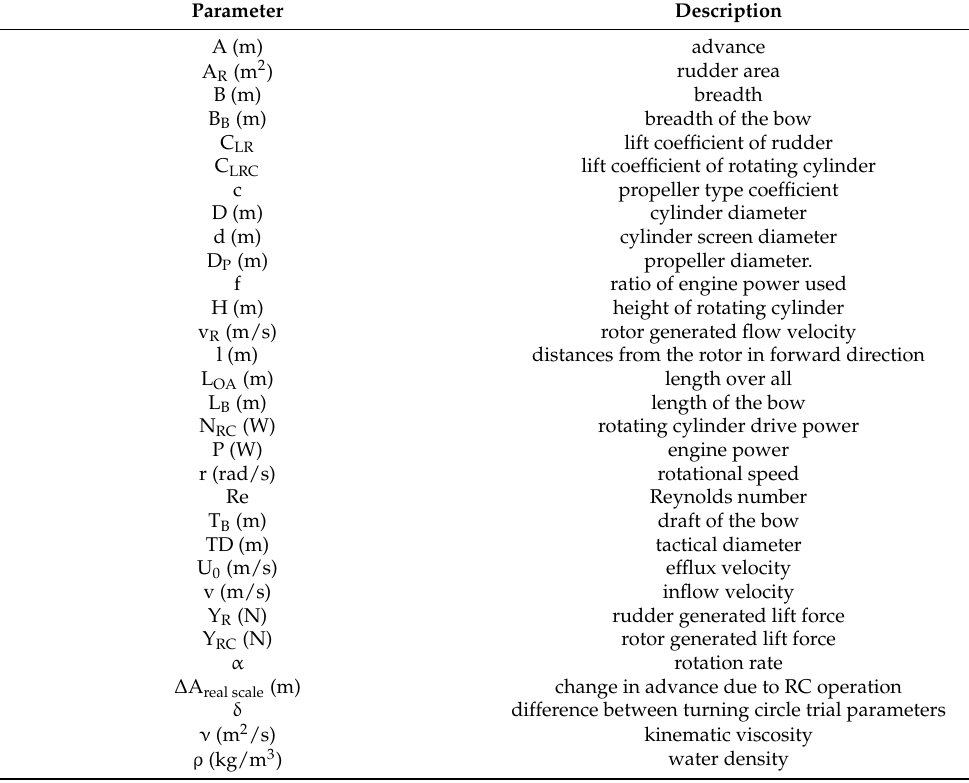
Table 1. Variables used in the paper.